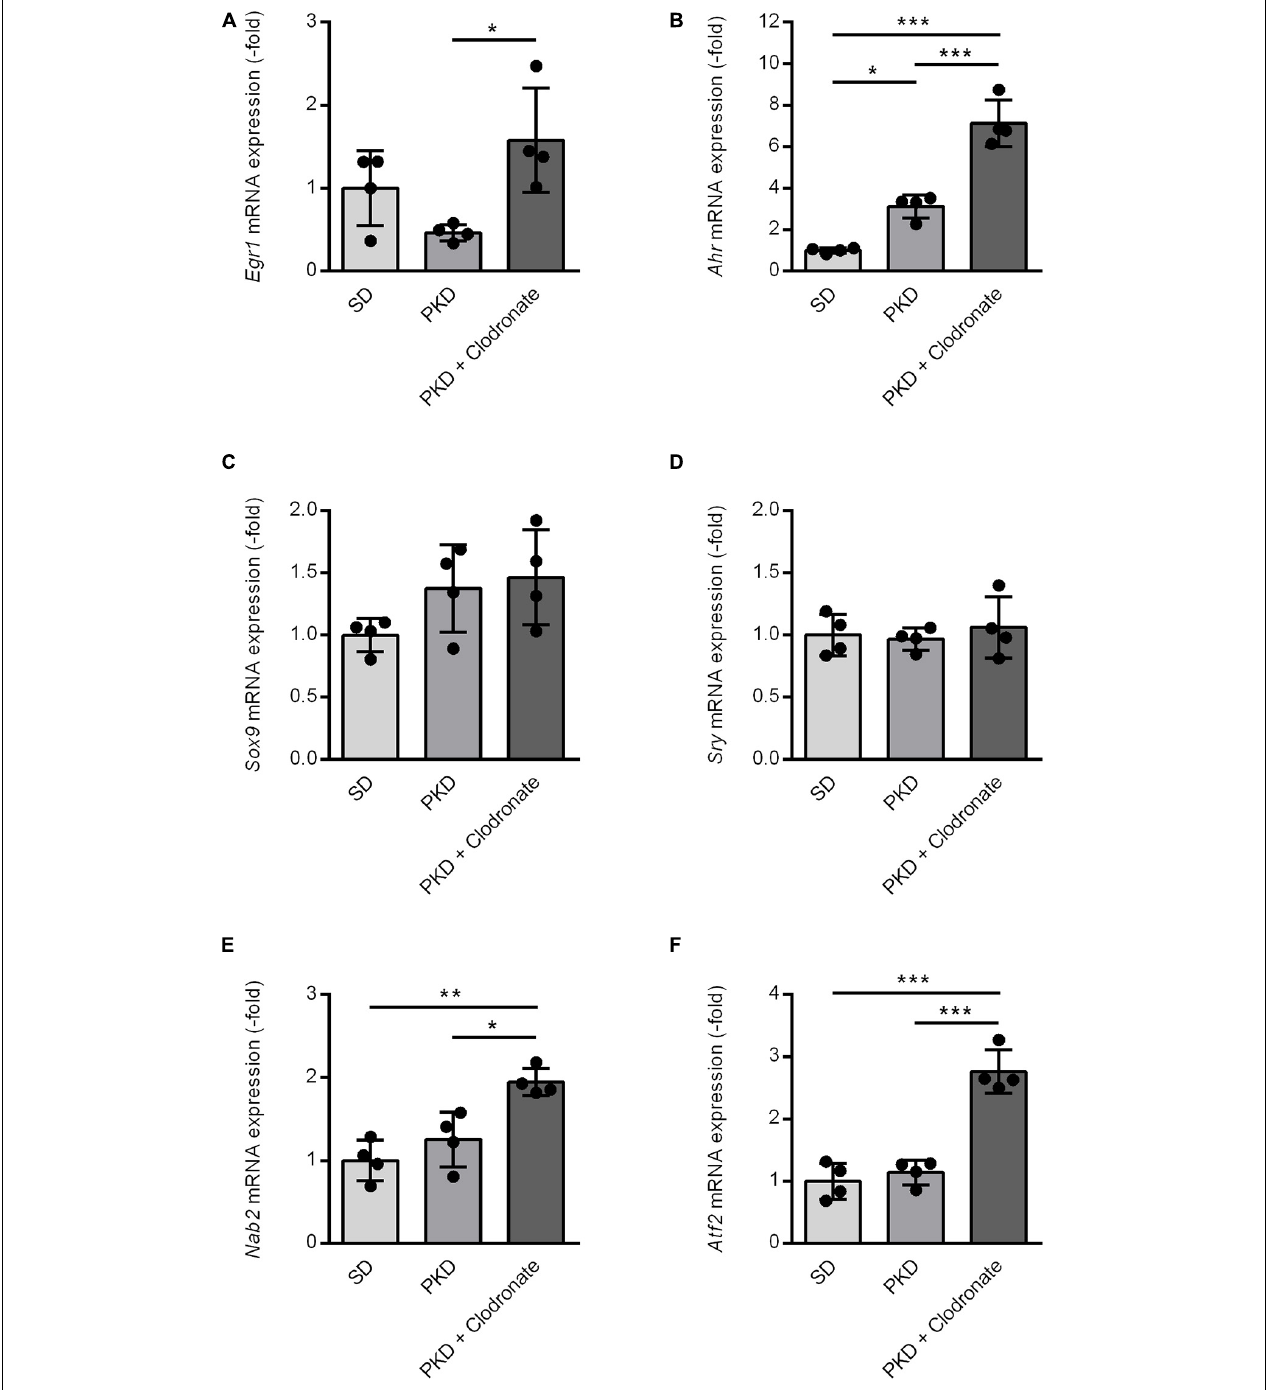
FIGURE 5 | Induction of vasoprotective and neuroprotective factors in clodronate-treated PKD rats. The mRNA expression of Egr1 (A) , Nab2 (E) , and Atf2 (F) was significantly increased compared to SD and PKD rats. The upregulation of Ahr (B) in PKD compared to SD rats was further enhanced in clodronate-treated animals. Sox9 (C) and Sry (D) showed no differences in mRNA expression between the three groups. * p < 0.05, ** p < 0.01, *** p < 0.001.